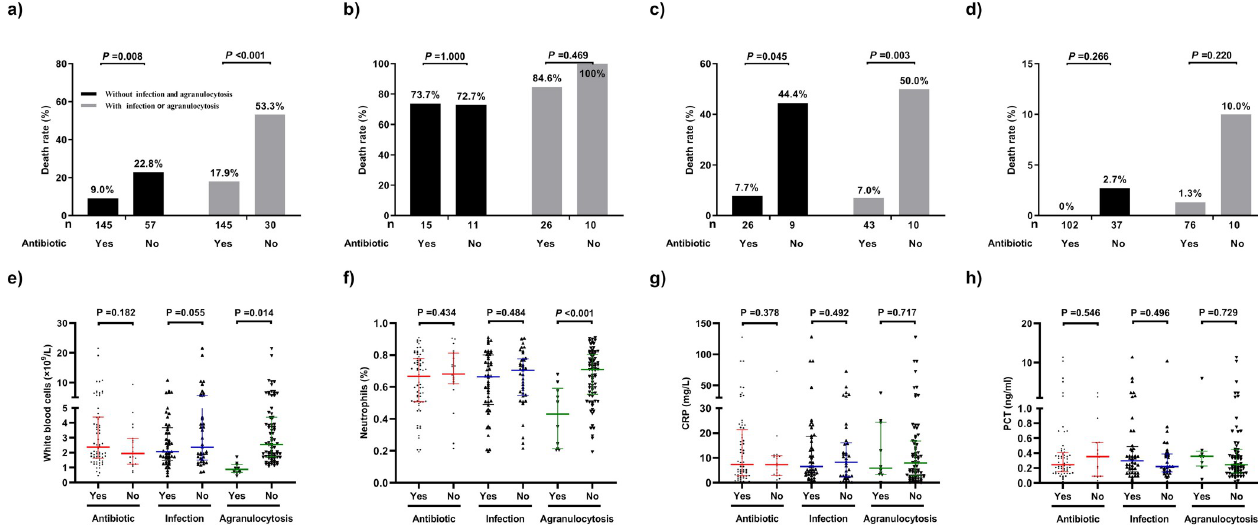
Fig 4. Subgroup analysis of the antibiotic effect on patients with severe fever with thrombocytopenia syndrome. (A) Overall analysis. (B) Double-positive group. (C) Single-positive group. (D) Double-negative group and analysis of inflammation indicators. (E) White blood cell (WBC). (F) N%. (G) Procalcitonin (PCT). (H) C-reactive protein (CRP) levels in the single-positive group (N = 88).